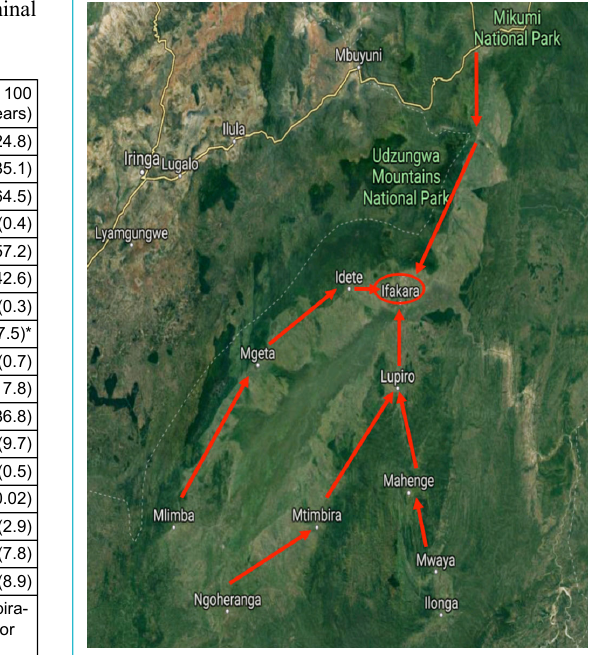
Figure 2: Map of the Kilombero valley and location of the villages where the patients come